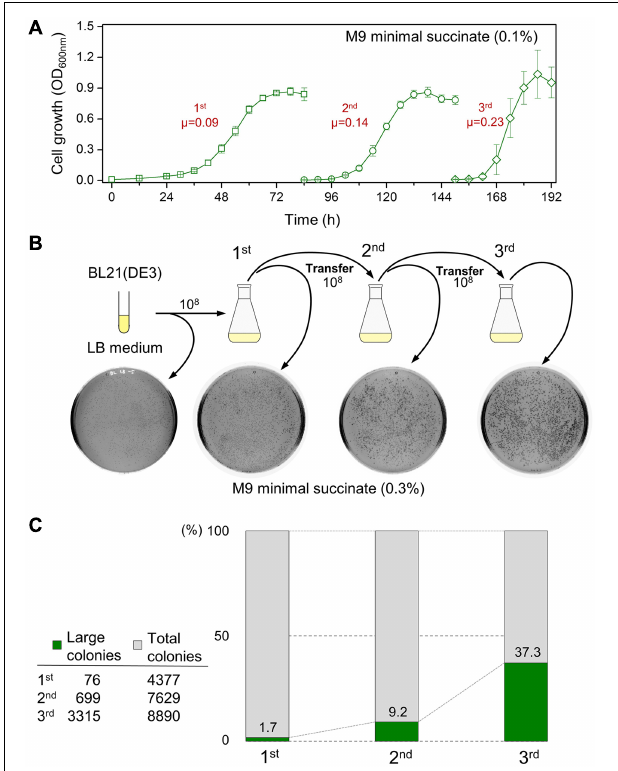
FIGURE 2 | The growth profile of the BL21(DE3) cells during continuous transfer to fresh M9 succinate medium and the analysis of the size of colonies from the cultures. (A) Accelerated cell growth by serial seed transfer to fresh succinate medium. The unit of specific growth rate ( µ ) is h - 1 . (B) The occurrence of large colonies and the increase in the number of large colonies from the cultures. (C) The ratio of the number of large to small colonies that grew after spread plating the culture